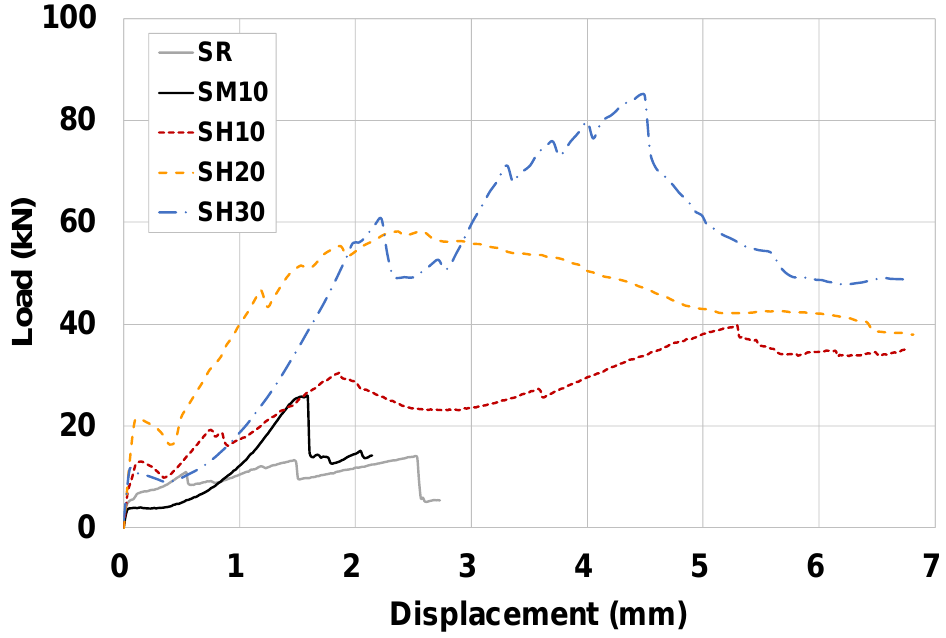
Figure 8. Load – displacement response of initial shear strength test: ( a ) SR; ( b ) SM10; ( c ) SH10; ( d ) SH20; ( e ) SH30.